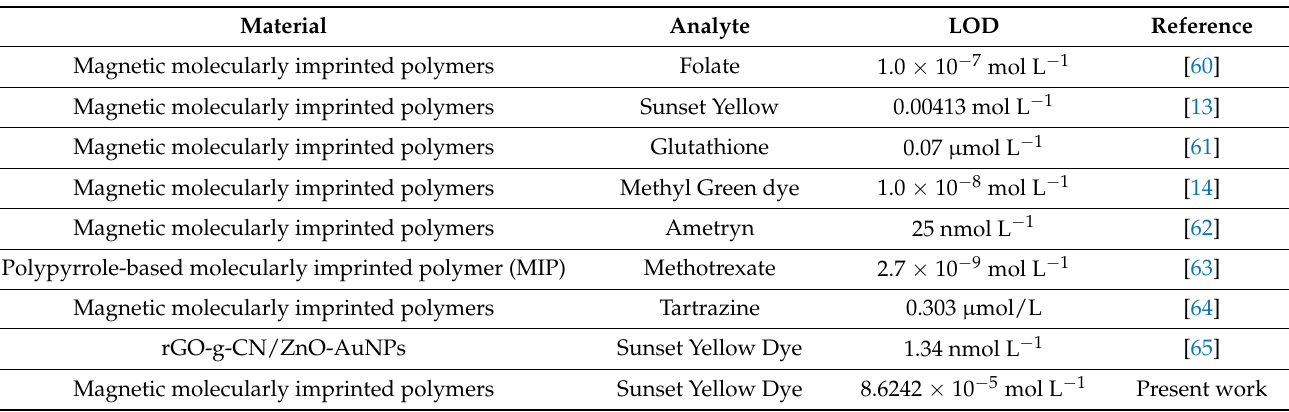
Table 4. Comparative study of analytical parameters obtained with different molecularly imprinted